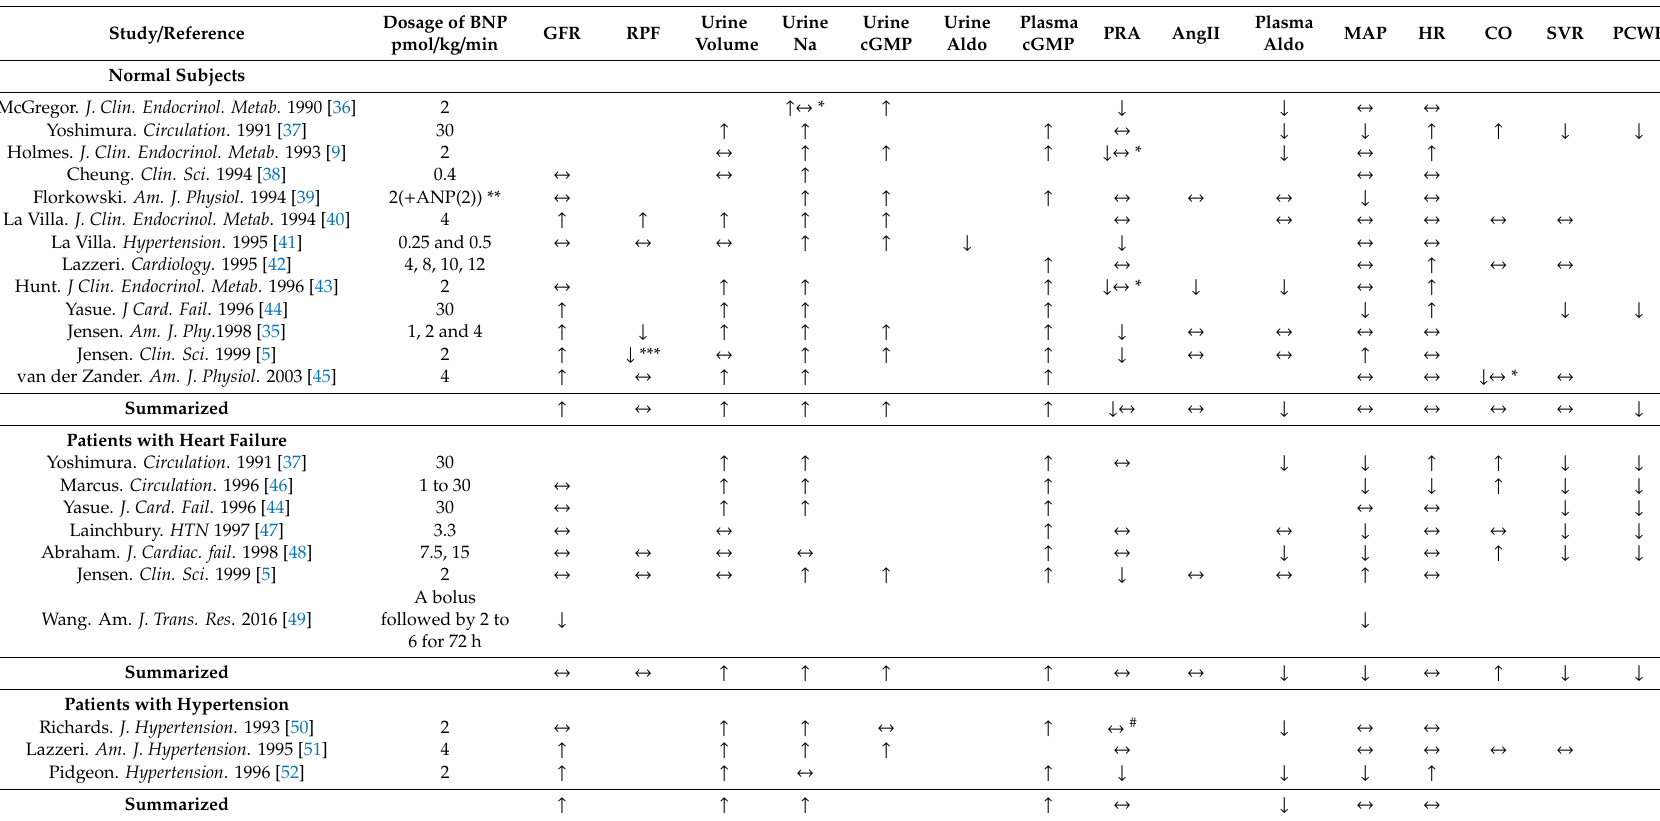
Table 1. The e ff ects of brain natriuretic peptide (BNP) infusion on renal function, the renin angiotensin II aldosterone system and hemodynamics in normal subjects and patients with heart failure and